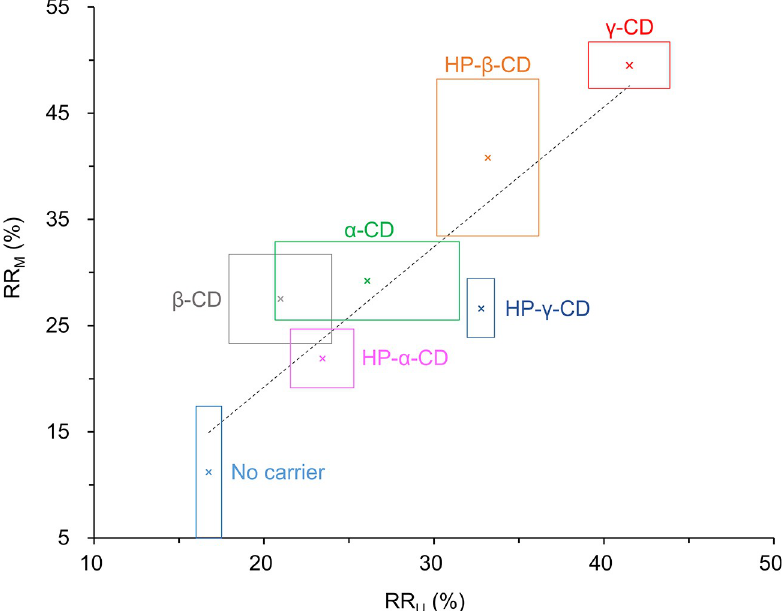
Fig 1. Correlation between the RR U and the RR M of doxorubicin when using different types of cyclodextrins as carriers. The cross marks represent the mean values, and the side lengths of the rectangles represent the SD. The Pearson’s correlation analysis shows a correlation coefficient of 0.90 (p = 0.006) which exhibits a high correlation between ultrafiltration and microdialysis.